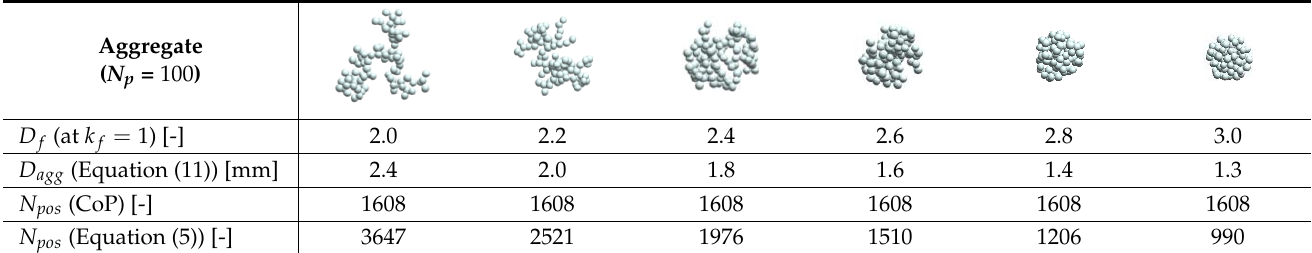
Table 2. The aggregates with their diameters (Equation (11)) and the number of positions calculated using the CoP approach and the new approach (Equation (5)).